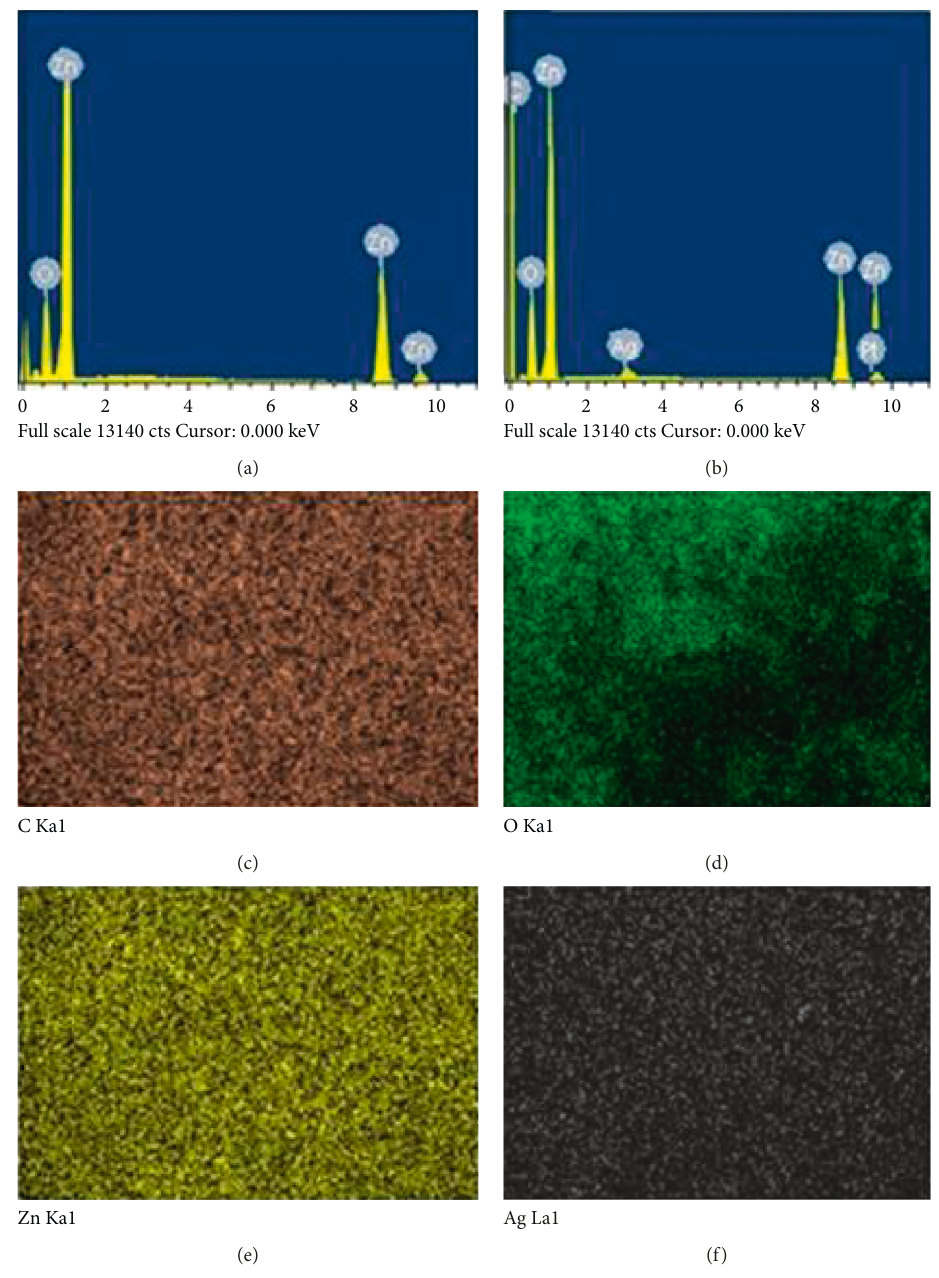
Figure 3: EDS and mapping analyses of synthesized